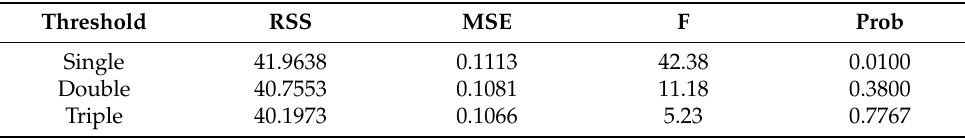
Table A2. Triple-threshold effect